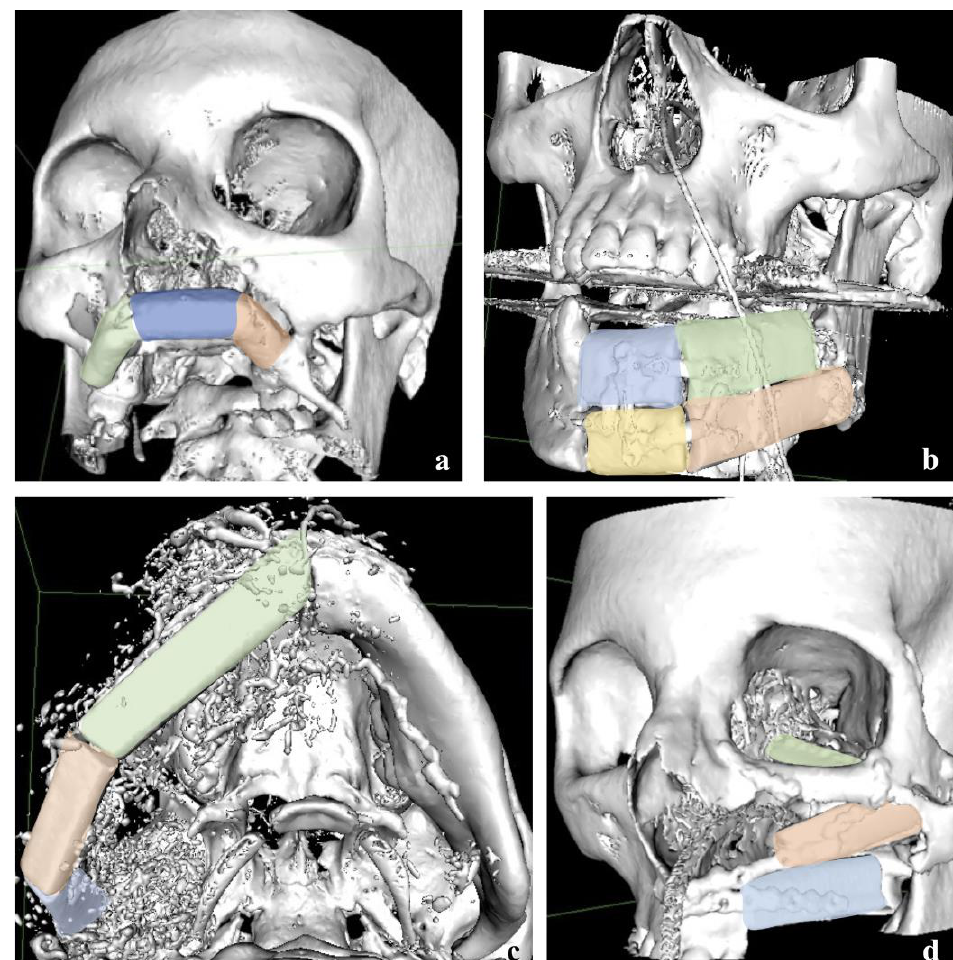
Figure 1. Examples of challenging reconstructive cases. ( a ) Three-pieces reconstruction of the whole maxilla due to excision of a chondrosarcoma in a young girl. ( b ) Double-barreled reconstruction of left body of the mandible following removal of an ameloblastoma. ( c ) Reconstruction of right hemimandible with free fibula flap in a three-pieces fashion. A widely extended arterio-venous malformation was removed after its embolization. Embolizing material artifacts are visible in the CT. ( d ) Midface reconstruction achieved by means of a free fibula flap in three segments after having removed a massive psammomatoid ossifying fibroma.